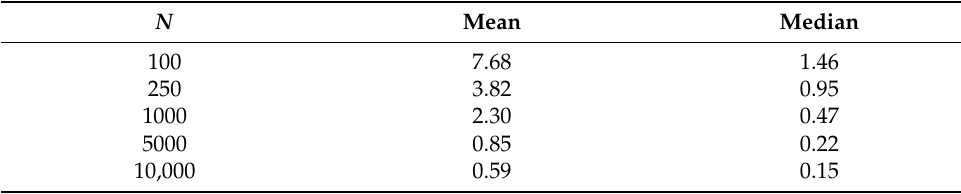
Table 5. Mean and median proportional absolute error over N .